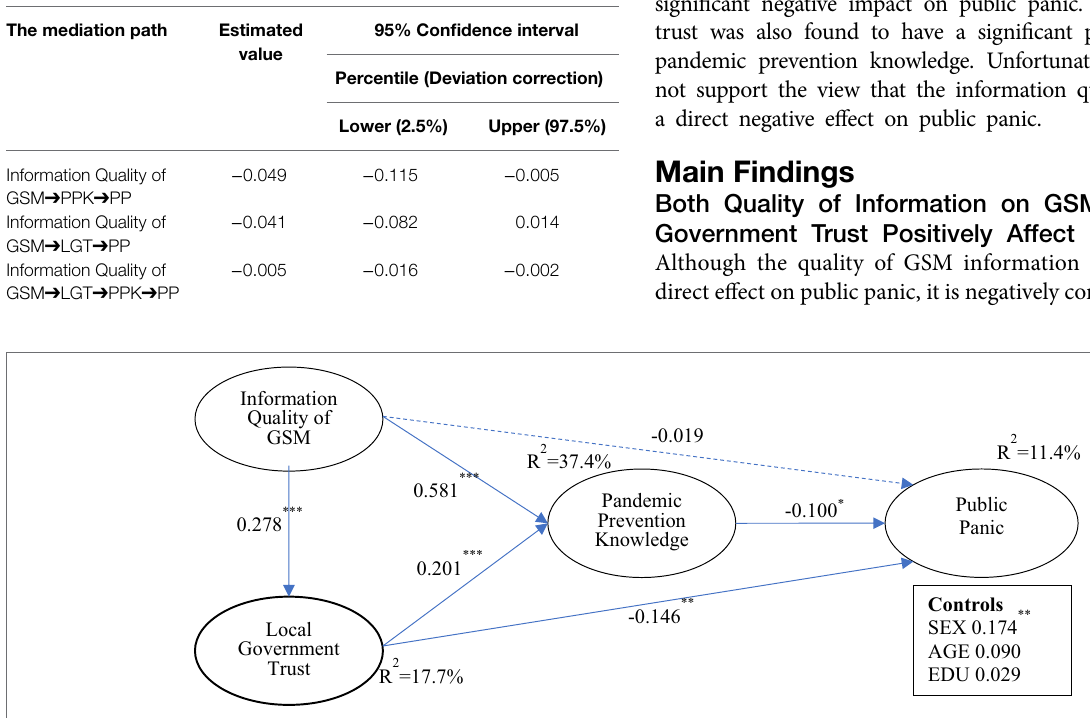
TABLE 3 | Bootstrapping analysis of the mediating